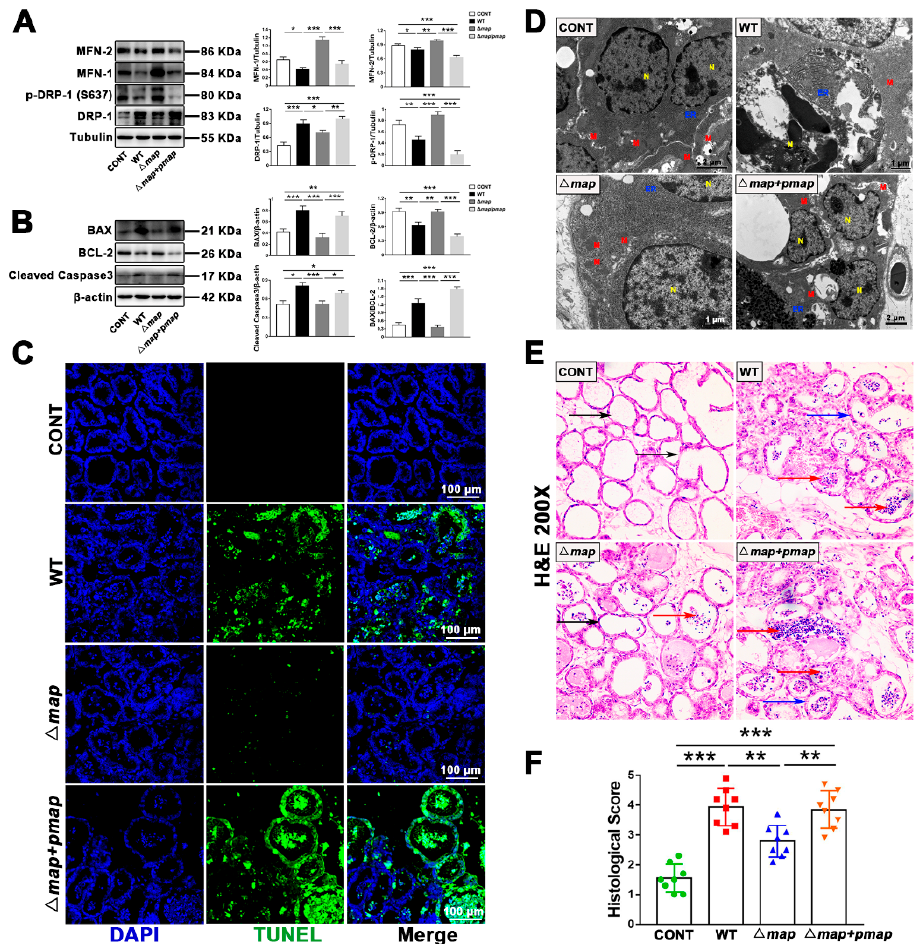
Figure 7. Map is required for E. coli (EPEC)-induced apoptosis in vivo. ( A ) The DRP-1, p-DRP-1 (ser637), MFN-1, and MFN-2 levels were analyzed by Western blot. ( B ) The BAX, BCL-2, and cleaved caspase-3 levels were analyzed by Western blot. ( C ) Apoptosis in the breast tissue was ac- cessed through TUNEL staining and DAPI (blue, nucleus). Scale bar, 100 µm. ( D ) Representative TEM images in each group. Red M, mitochondria; yellow N, nucleus; blue ER, endoplasmic reticu- lum. Scale bar, 1 µm and 2 µm. ( E ) The pathological damage of breast tissue was evaluated by H & E staining (×200). The black arrow points to the normal tissues. The red arrow represents inflamma- tory cell infiltration. The blue arrow points to the alveolar wall hyperplasia. Histopathological scores ranged 1–5: (1) no obvious histological changes; (2) minimal histopathological changes (i.e., individ- ual neutrophils); (3) mild histopathological changes (i.e., a few neutrophils); (4) moderate histolog- ical injury (i.e., many neutrophils and slight glandular structure damage); and (5) severe histological injury (i.e., numerous neutrophils and severe glandular structure damage). A mouse mastitis model was established by injecting WT, map mutant ( ∆ map ), and complementary strain ( ∆ map + pmap ) (1 × 10 6 CFU/30 mL saline) into a mammary duct 24 h after infection. These mice were euthanized and mammary tissue samples were collected. Data are from 3 independent experiments and presented as the mean ± SEM; * p < 0.05, ** p < 0.01, *** p < 0.001. 3. Discussion and Conclusions A growing number of viral and bacterial proteins are considered to target host mito- chondria and play an important role in the pathogenesis as regulators of apoptosis [22]. Map, as an important virulence factor of EPEC, has been reported to induce host cell apop- tosis, but its specific pathogenic molecular mechanism is not clear in bovine mastitis. In this study, we proposed for the first time that the map gene can induce DRP-1-mediated mitochondrial fission, leading to mitochondrial dysfunction and apoptosis in EPEC-in- duced bovine mastitis.